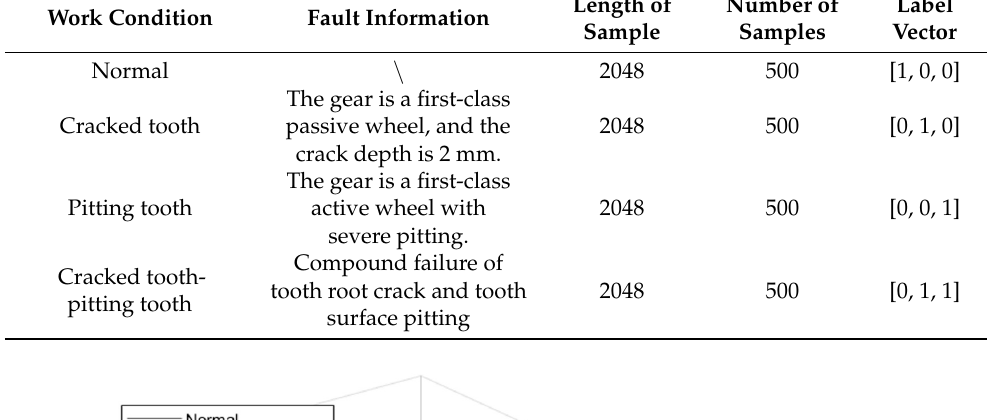
Table 6. Description of gearbox failure simulation dataset.